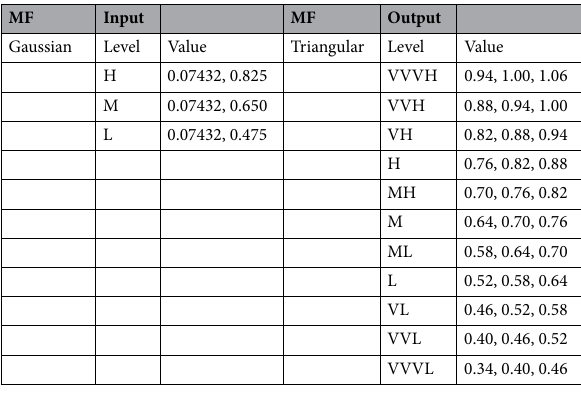
Table 11. Fuzzy subsets parameter of input and